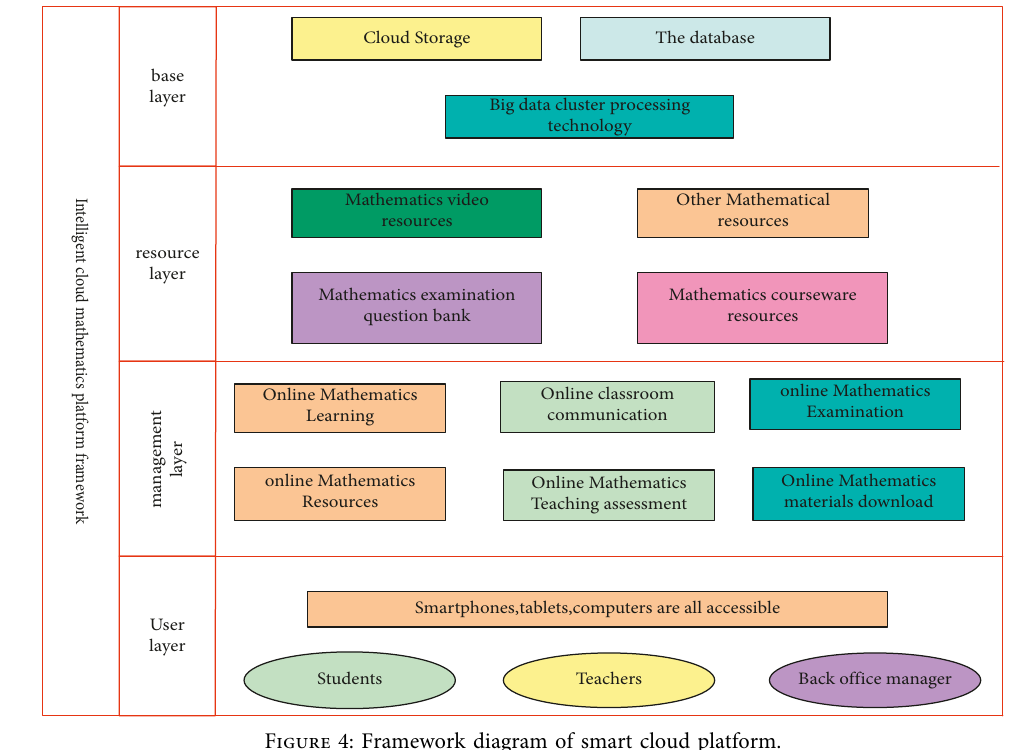
Figure 4: Framework diagram of smart cloud platform.